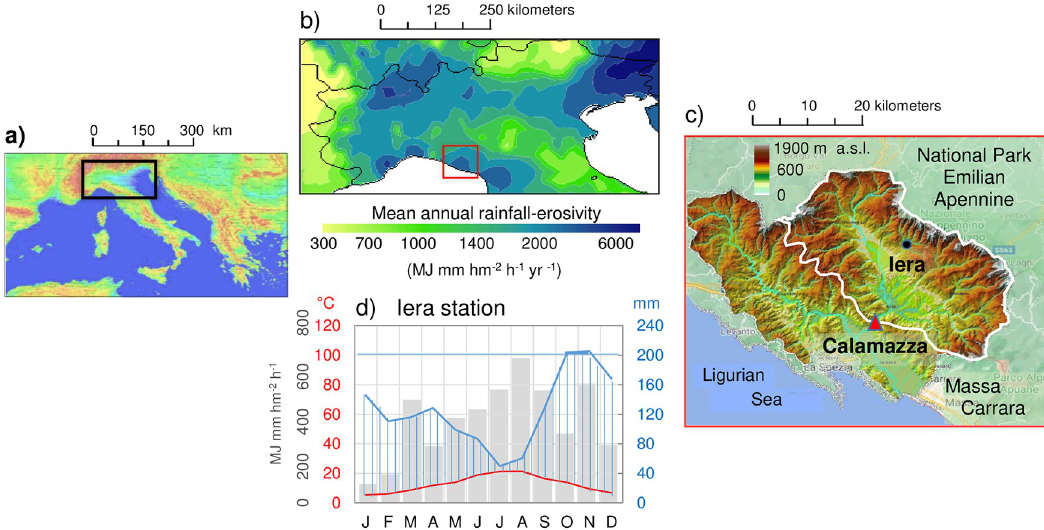
Fig 1. Environmental framework of the Magra River Basin. a) northern sector of Italy in the central Mediterranean area, b) rainfall erosivity map of northern Italy [31] with the study area (red square), c) digital elevation model of the basin with the basin outlet at the hydrometric station of Calamazza (red triangle) and the reference pluviometric station of Iera (black dot), d) monthly rainfall erosivity (grey bars, MJ mm hm -2 h -1 month -1 ), and Walter-Lieth diagram showing the monthly regime of air temperatures (red curve) and precipitation (blue curve, with blue areas in February and November indicating that precipitation exceeds 200 mm in these months). Maps are authors’ own elaboration from free, public domain, images: a) extraction from Geological Survey of Italy Portal (http://sgi2.isprambiente.it/viewersgi2); b) analysis from ArcGIS-ESRI Geostatistical Analyst on the ESDAC (European Soil Data Centre) dataset (https://esdac.jrc.ec.europa.eu/content/global-rainfall-erosivity) and c) adaptation from Magra River Basin Authority [32]”.